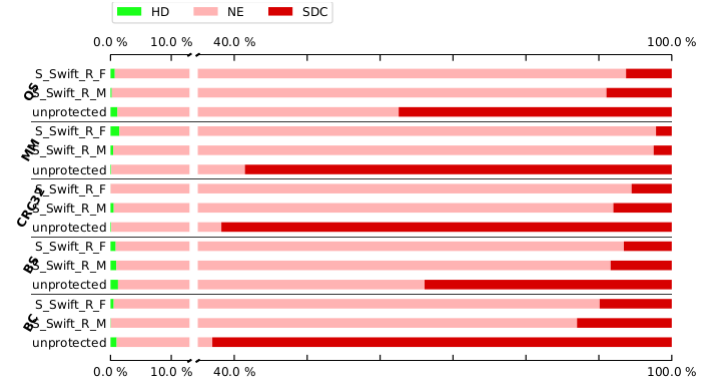
Figure A5. CFE fault injection results for 3 registers.